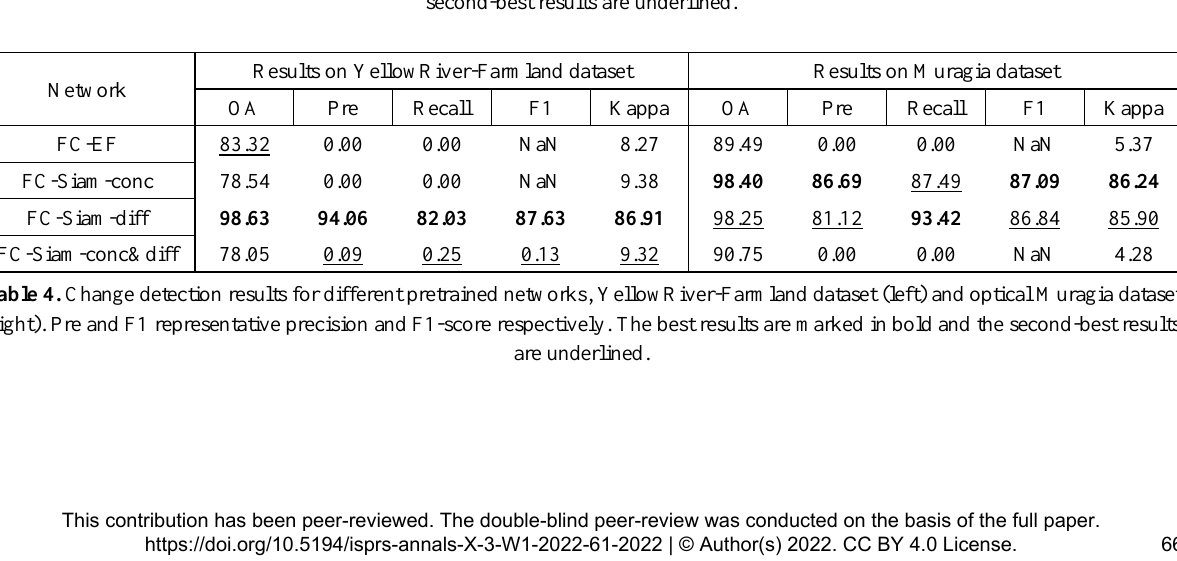
Table 3. Change detection results for different pretrained networks on the SAR dataset, Sulzberger dataset (left) and YellowRiver- Inland dataset (right). Pre and F1 representative precision and F1-score respectively. The best results are marked in bold and the second-best results are underlined.